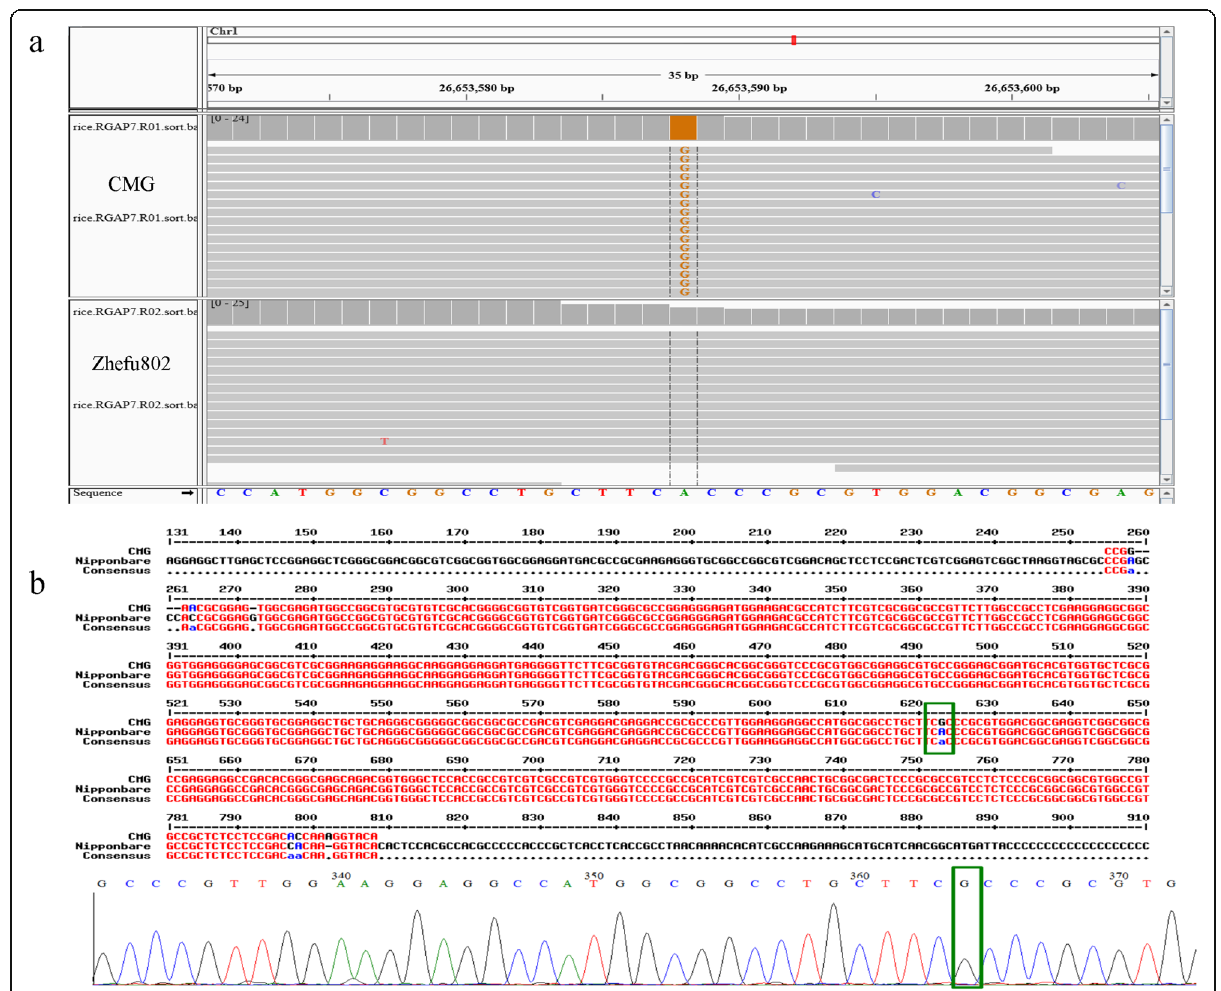
Fig. 6 Detection and validation of the candidate gene OsPP2C tolerant to salt at the seedling stage. a : The detected sequence variant of OsPP2C based on genome sequencing; b : sequencing and alignment of amplified PCR products using the specific primers for